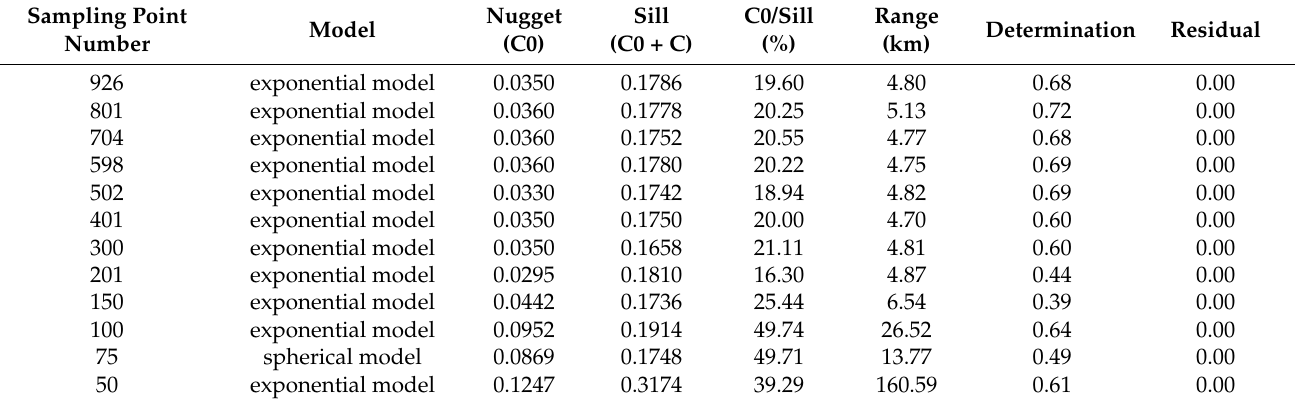
Table 2. Parameters of semi-variance function of soil pH under different sampling